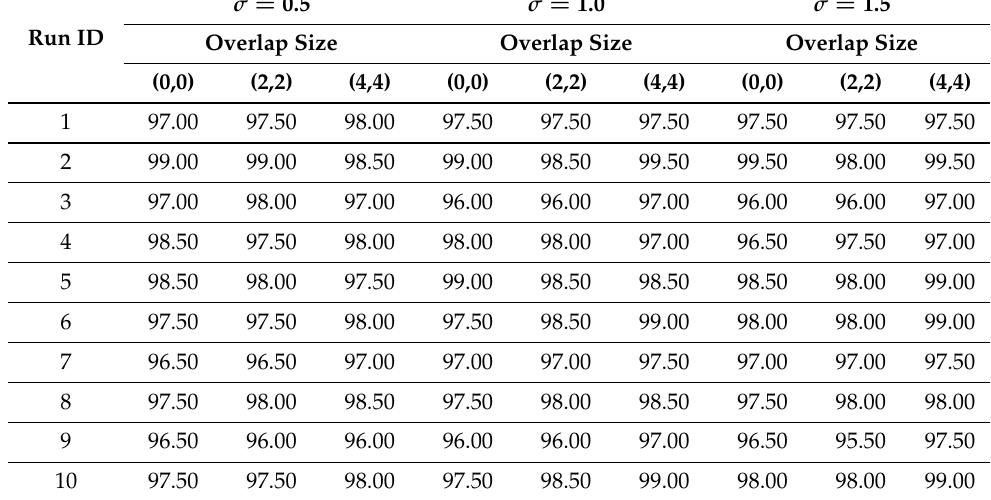
Table A3. The results of the runs for Gaussian noise with standard deviation of 0.05 using different values of σ